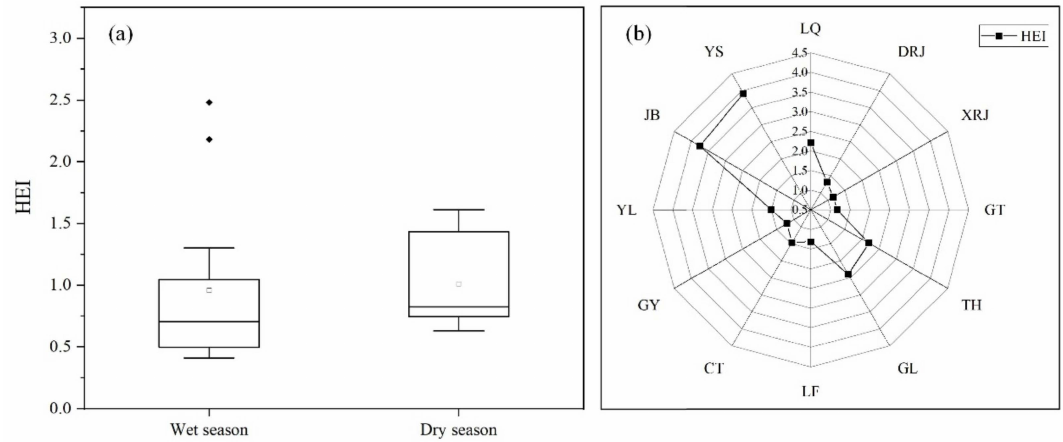
Figure 4. Seasonal ( a ) and spatial ( b ) variation of